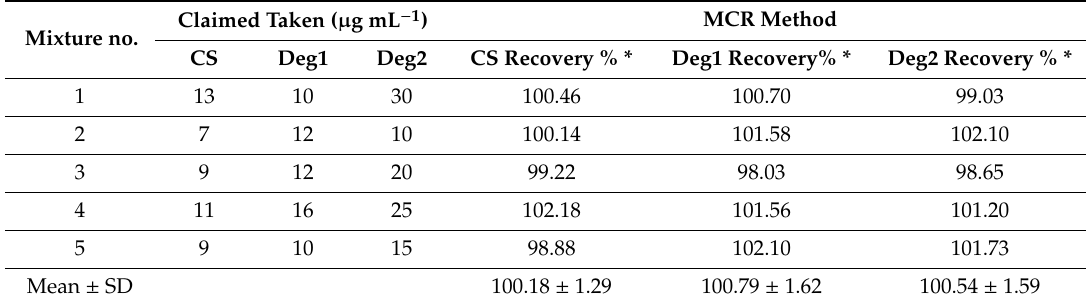
Table 2. Determination of CS, Deg1 and Deg2 in laboratory prepared mixtures by MCR method. Mixture